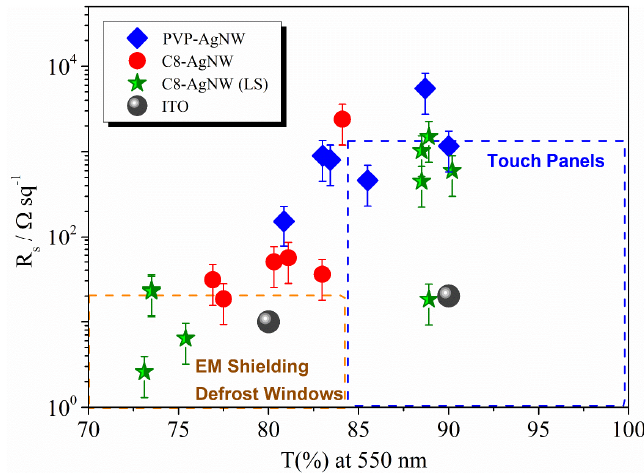
Figure 6. Variation of R s with T (%) for films obtained with different nanowires and deposition methodologies: PVP ‐ AgNWs Spray (diamonds), C8 ‐ AgNWs by Spray (circles) and C8 ‐ AgNWs by LS (stars). Gray circles correspond to representative values for Indium Tin Oxide [4,35].